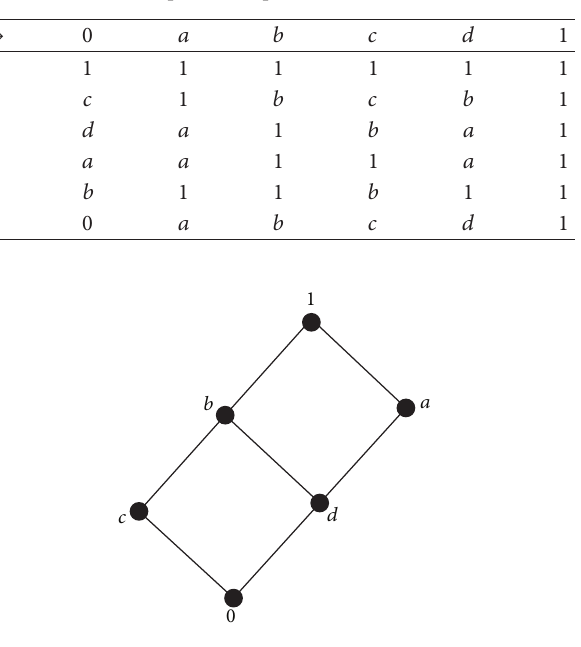
Figure 1: Hasse diagram of 𝐿 2 = {0, 𝑎,𝑏, 𝑐, 𝑑, 1}